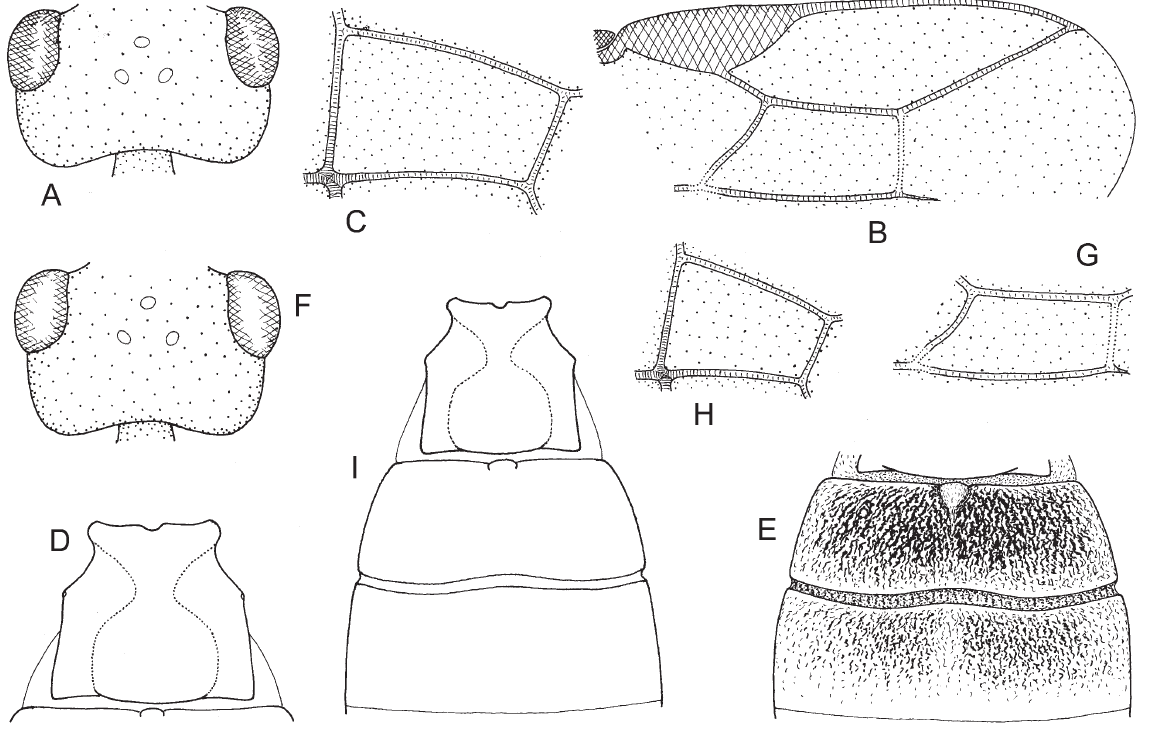
Fig. 11. Bracon ( Lucobracon ) fortipes Wesmael, 1838 (A-D: ♀, E-I: ♀ / ♂). A . Head in dorsal view. B . Distal part of right forewing. C . First discal cell of right forewing. D . First tergite. E . Tergites 2-3. F . Head in dorsal view. G . Second submarginal cell. H . First discal cell of right forewing. I . Tergites